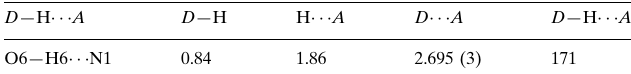
Agilent SuperNova Dual diffractometer with an Atlas